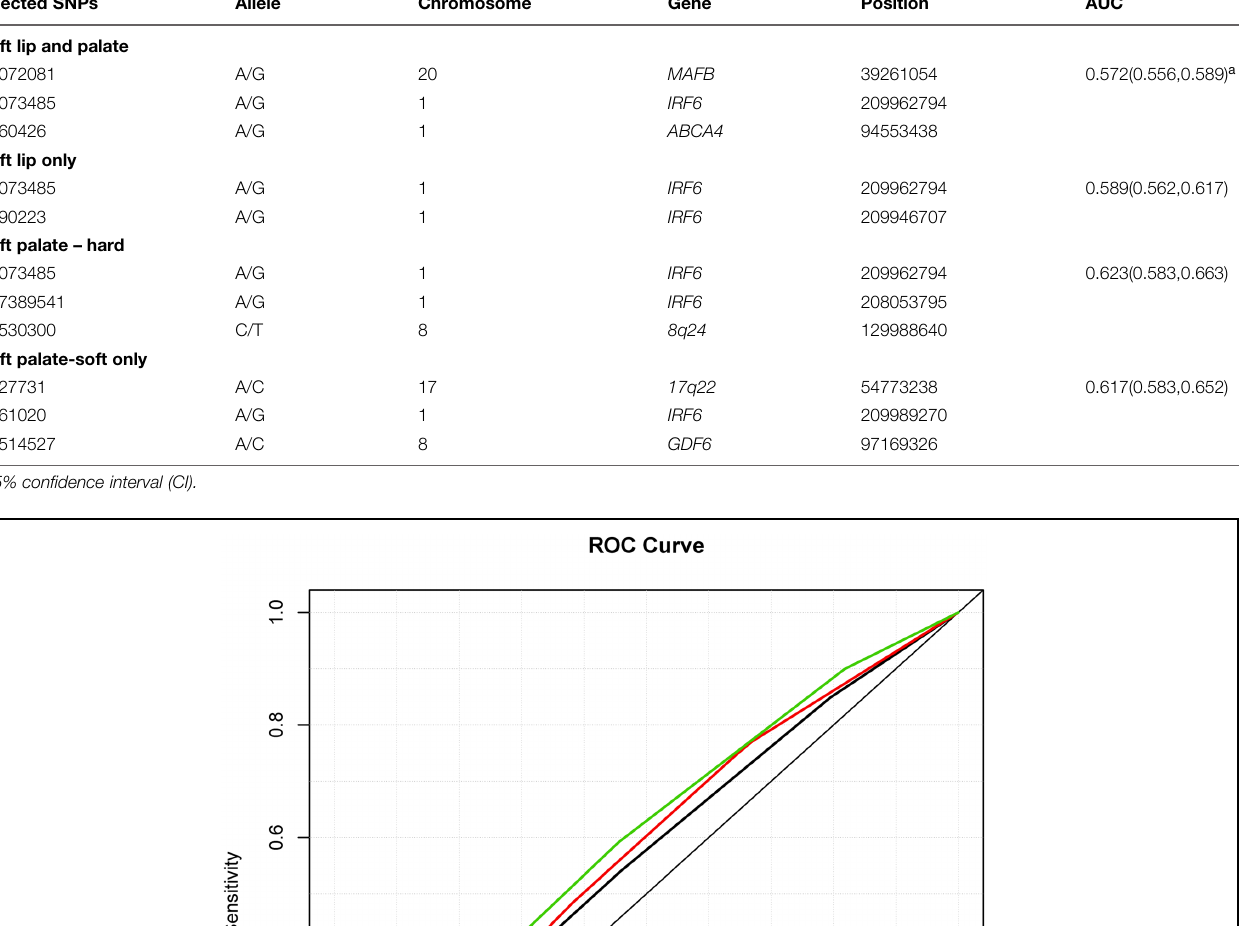
a single entity by the MLRE method. The CL risk prediction model ( Figure 1 ) with rs2073485 ( IRF6 ) and rs590223 ( IRF6 ) selected as risk predictors has an AUC value of 0.589 with 95% CI of (0.562, 0.617). Contrary to most of the current